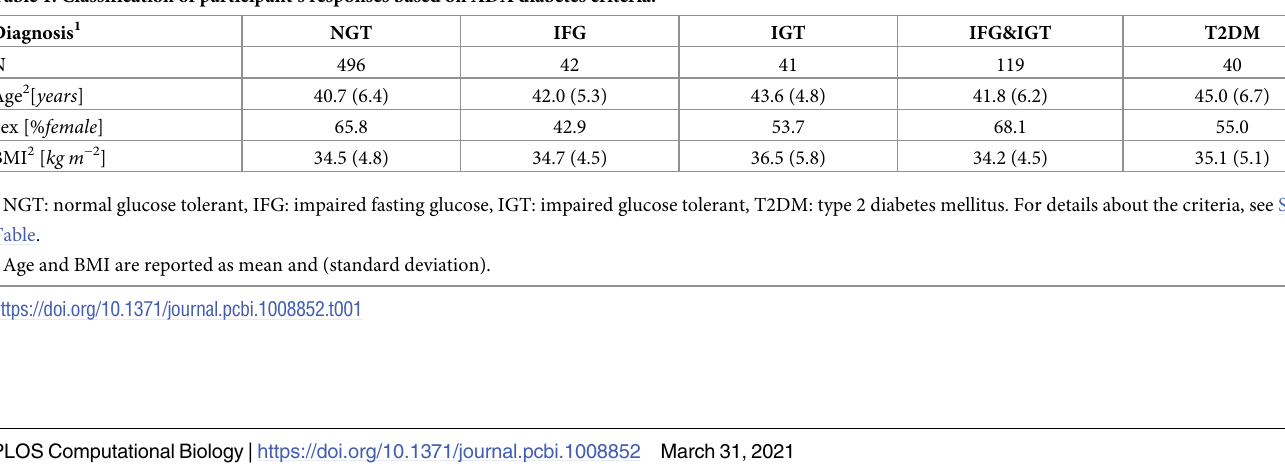
Table 1. Classification of participant’s responses based on ADA diabetes